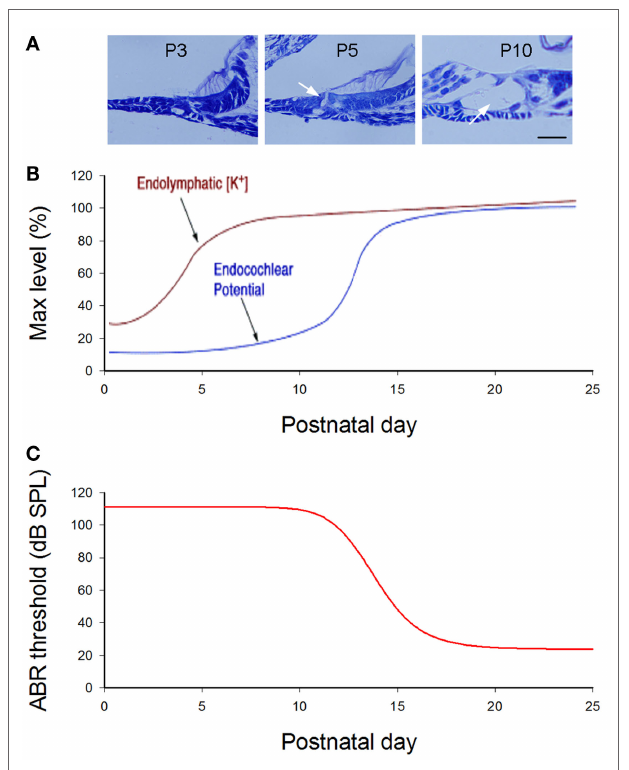
FiGuRe 2 | Cochlear postnatal development and functional maturation in mice . (A) Postnatal development of the cochlea. Arrows indicate that the cochlear tunnel starts to open at postnatal day 5 (P5) and fully opens at P10. (B) Postnatal developments of endocochlear potential (EP) and [K + ]. Modified from Hibino et al. (2004). (C) Hearing maturation in mice. ABR thresholds dramatically drop at P11–16 and reach normal levels around P20. Modified from Liang et al.